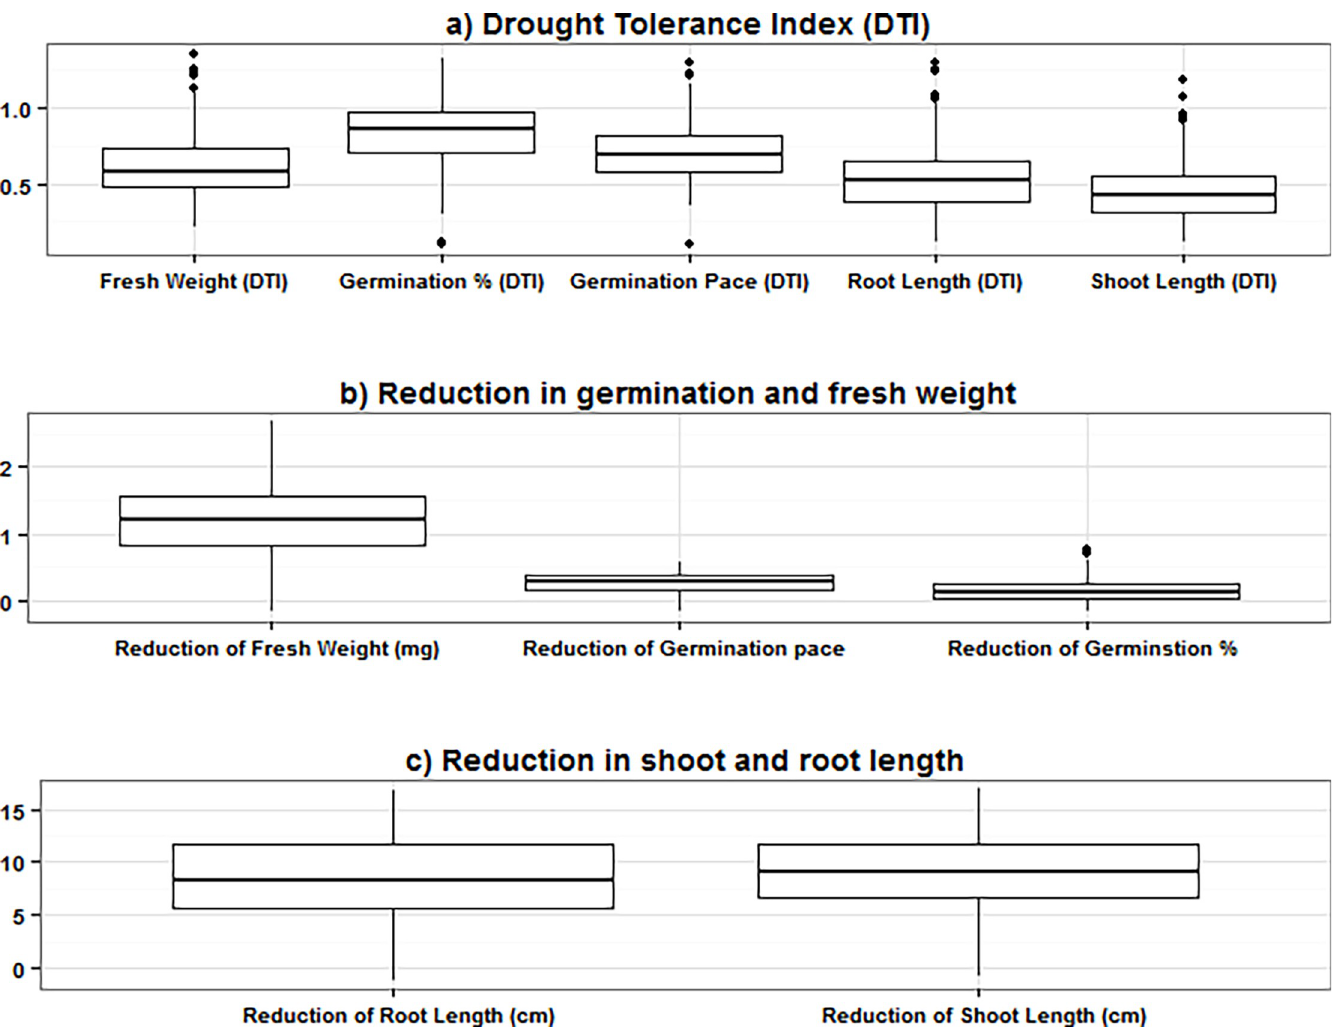
Fig 2. Boxplot analysis of variation of the traits; a) Drought tolerance index, b) Reduction in germination and fresh weight, c) Reduction in the shoot and root length in barley genotypes under control and drought stress (20% PEG).